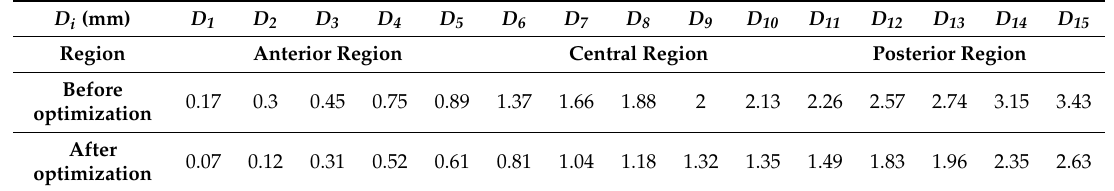
Table 5. Height variable Di before and after